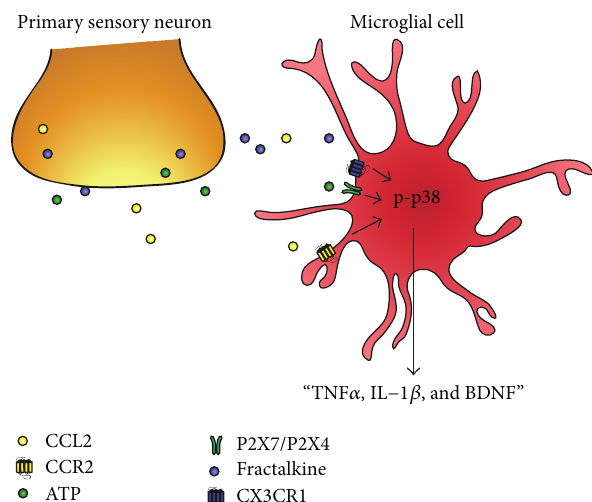
Figure 2: Schematic of primary afferent releasing factors that are responsibleformicroglialactivation.Microglialcellsareactivatedby factors released from hyperexcitable primary afferents such as CCL2 (MCP-1), ATP, and CX3CL1 (fractalkine). Respective activation of CCR2, P2X4/P2X7, and CX3CR1 receptors on microglia causes phosphorylation of p38 in microglia, leading to increased synthesis and release of TNF 𝛼 , IL-1 𝛽 , and